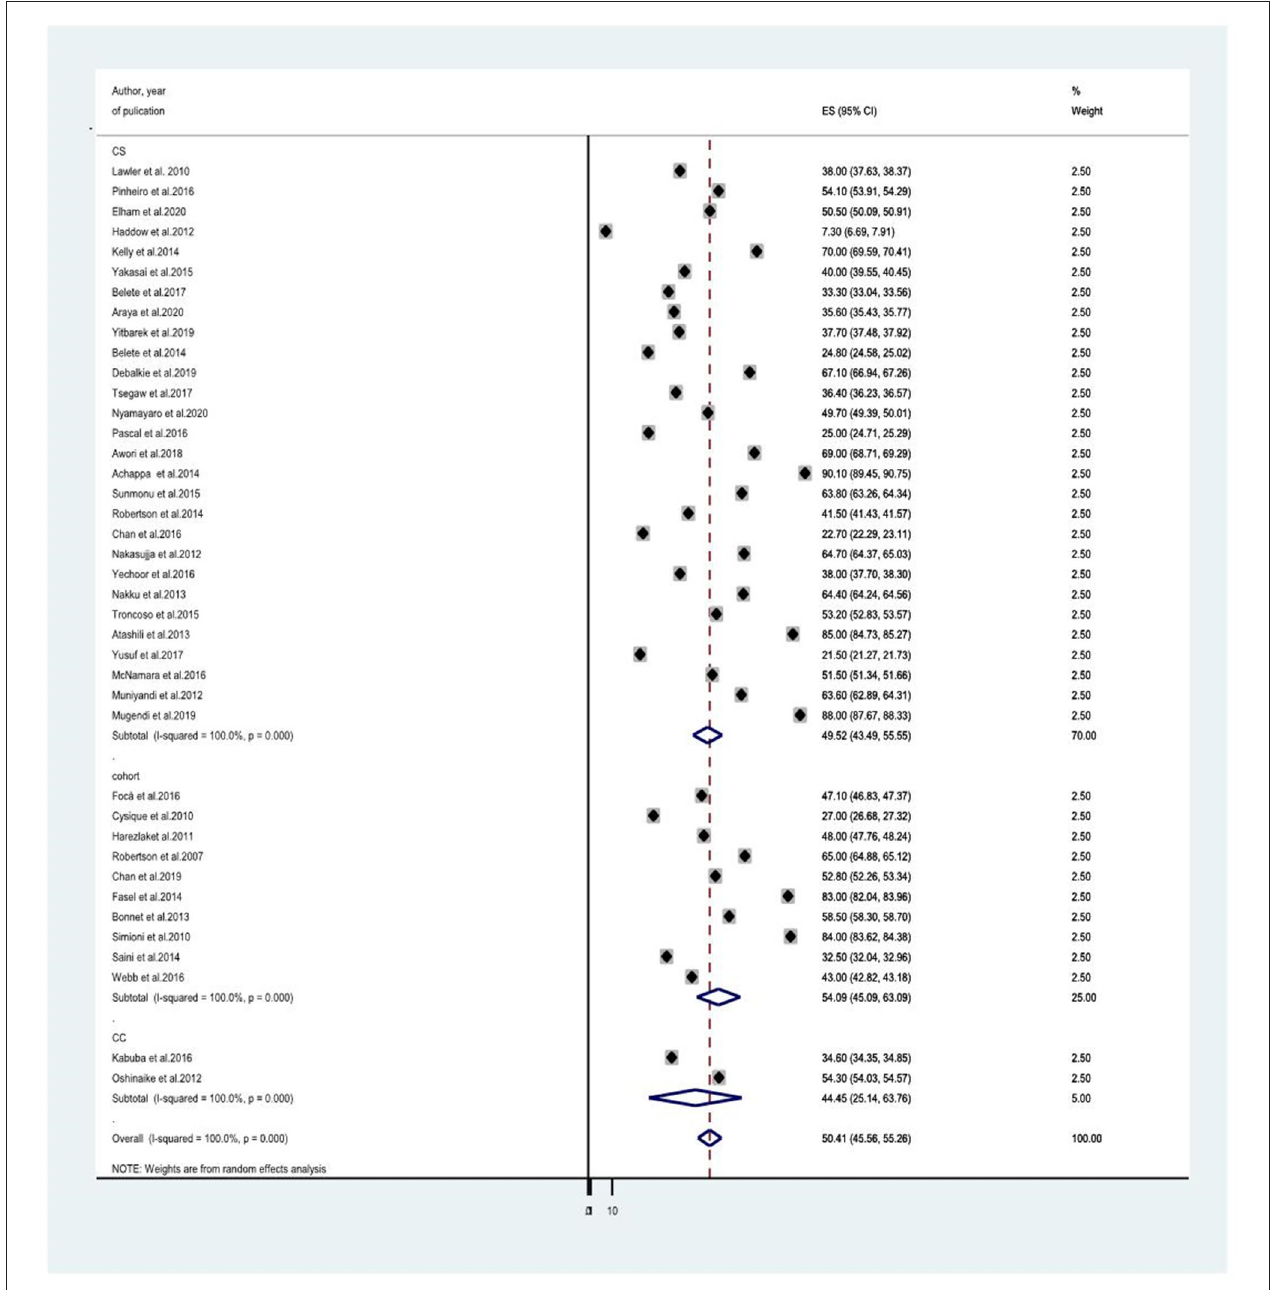
FIGURE 5 | A subgroup analysis for the prevalence of HIV associated neurocognitive disorders based on country of study tools.